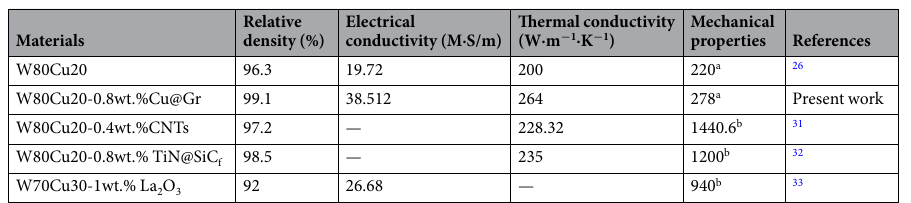
Table 1. Comparison of physical and mechanical properties of W80Cu20 composites with those from literature. a Hardness (HV) value. b Transverse rupture strength (TRS, MPa)